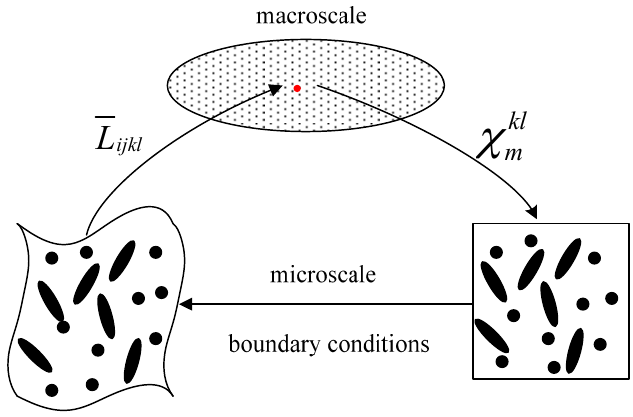
Figure 1 . Computational homogenization schemes.